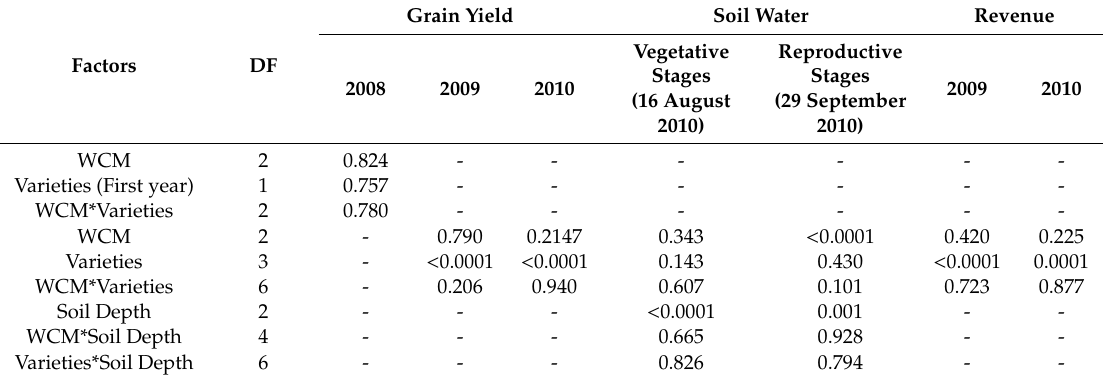
Table 1. Analyses of variance results ( probability -values) for grain yield, soil water, and revenue.